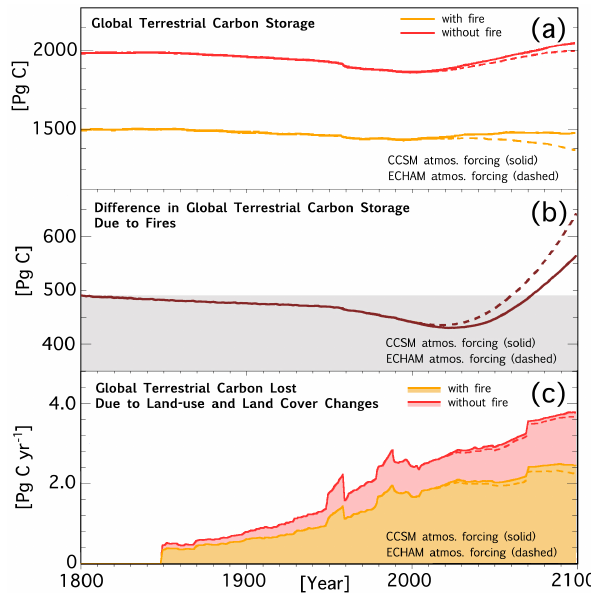
Fig. 5. Timeseries of (a) the total C stored in terrestrial ecosystems, (b) the difference in total C stored in terrestrial ecosystems between the CLM NOFIRE and CLM FIRE simulation sets (see Table 2), and (c) the total C lost due to land use and land cover changes, plotted for the CLM NOFIRE simulations (red; (a) and (c) ) and the CLM FIRE simulations (orange; (a) and (c) ). The shaded region in (b) indicates when the change in carbon storage due to removing fires is less than the initial (year 1798) value. C lost from land use and land cover change is defined as the C flux to the atmosphere from recategorization of land cover (for example, from forest to crops) and wood